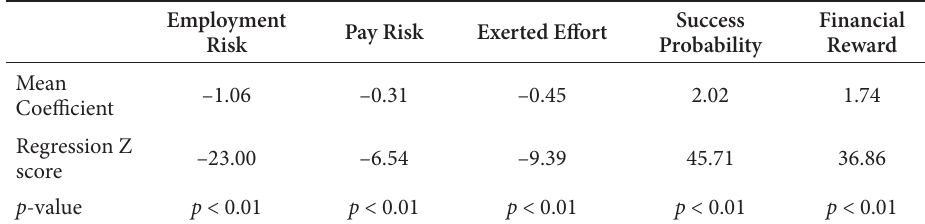
Table 2. Z scores and significance of regression